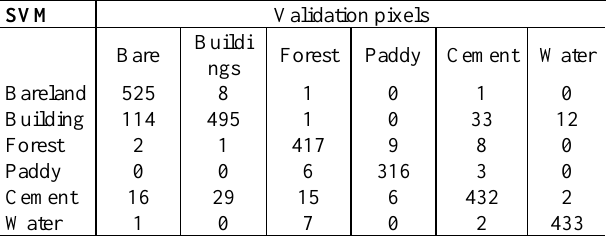
Table 7. Confusion matrix of SVM on Hamburg image